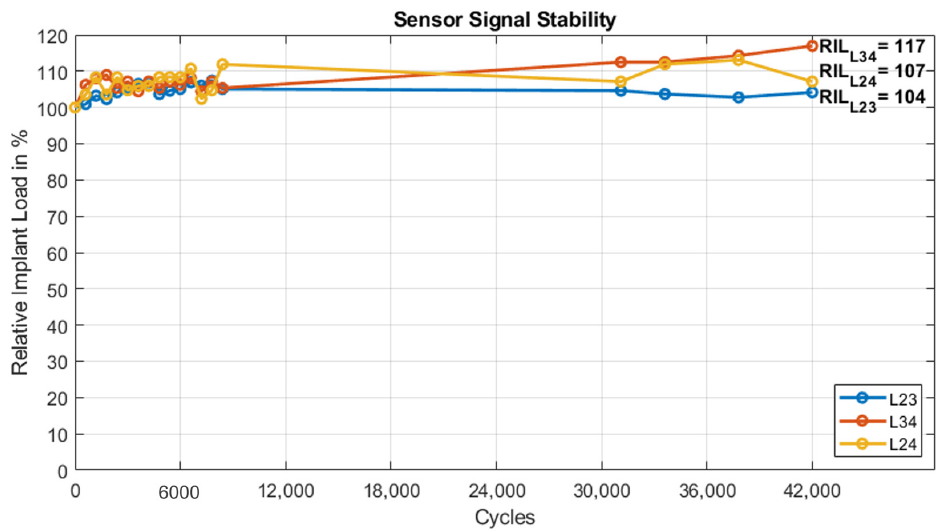
Figure 8. Relative implant load (RIL) during in vitro flexion-extension loading over 42,000 cycles for all sensors. Circles mark the data acquisition points.